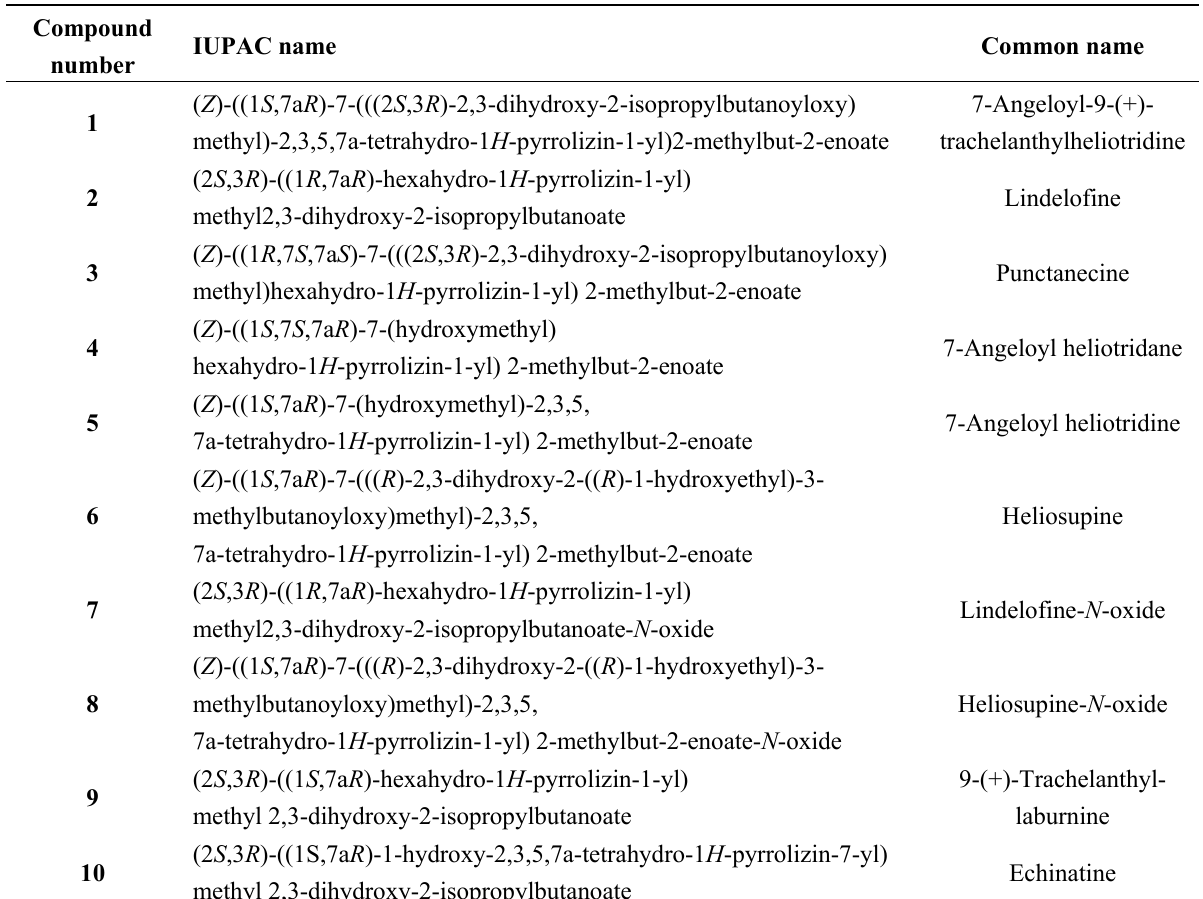
Table 1. IUPAC and common names of isolated PAs.